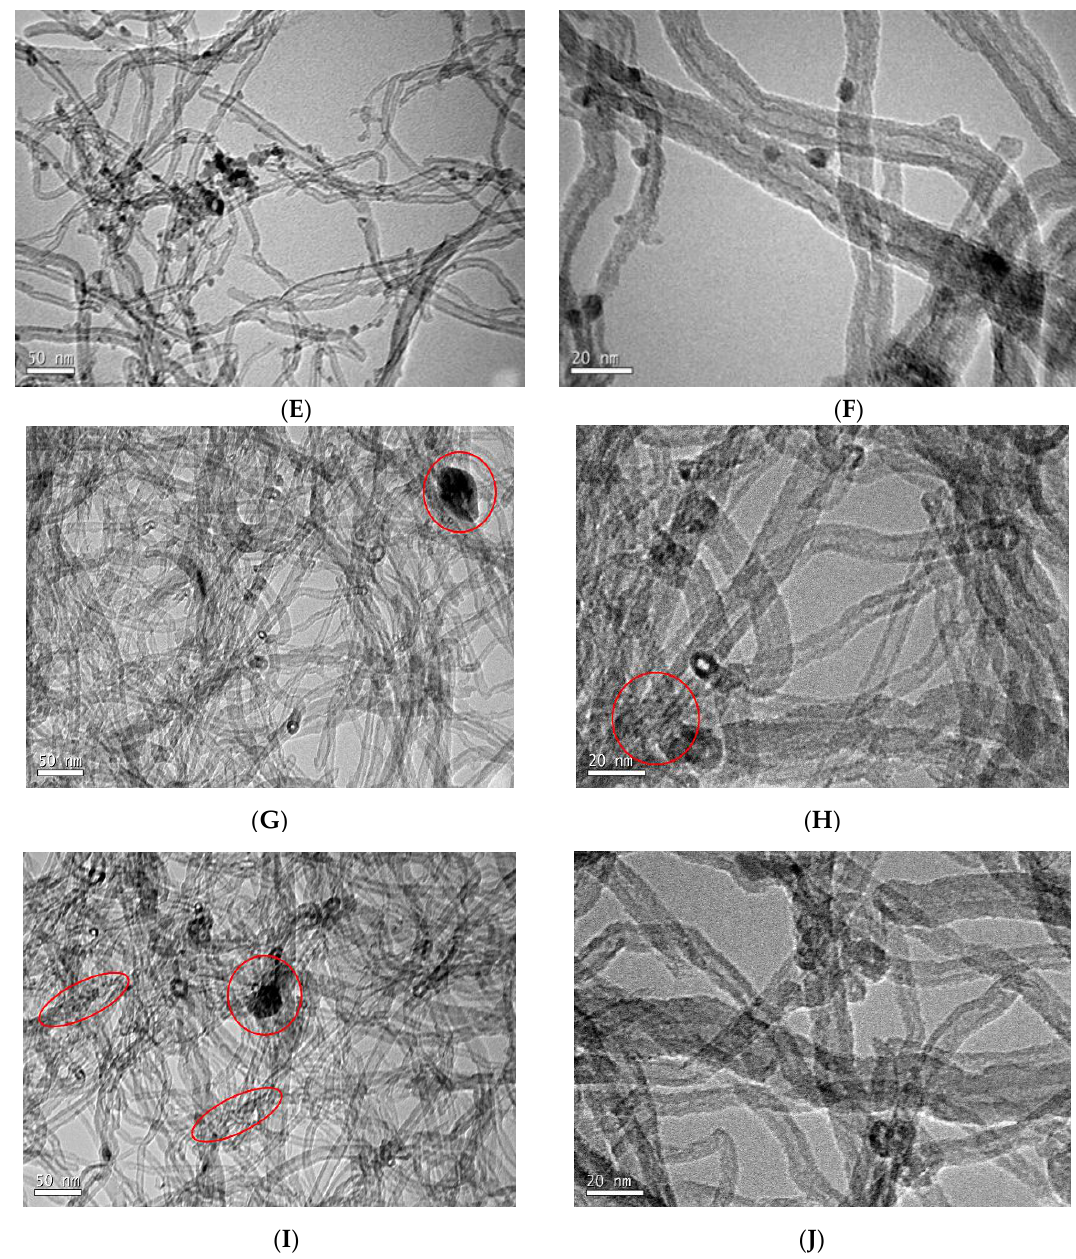
Figure 2. HRTEM images of Fe 100 − x Cu x / CNT. ( A , B ): Fe 100 / CNT; ( C , D ): Fe 75 Cu 25 / CNT; ( E , F ): Fe 50 Cu 50 / CNT; ( G , H ): Fe 25 Cu 75 / CNT and ( I , J ): Cu 100 / CNT. The presence of Cu and / or Cu 2 O particles is marked with red circles in Figures ( G – I ).